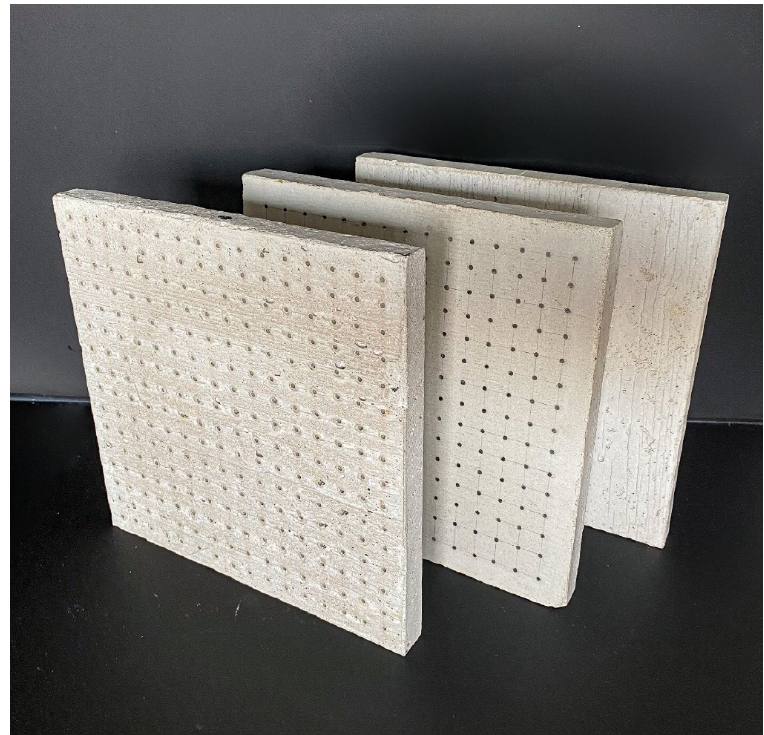
Figure 8. Samples of three types of used slabs.